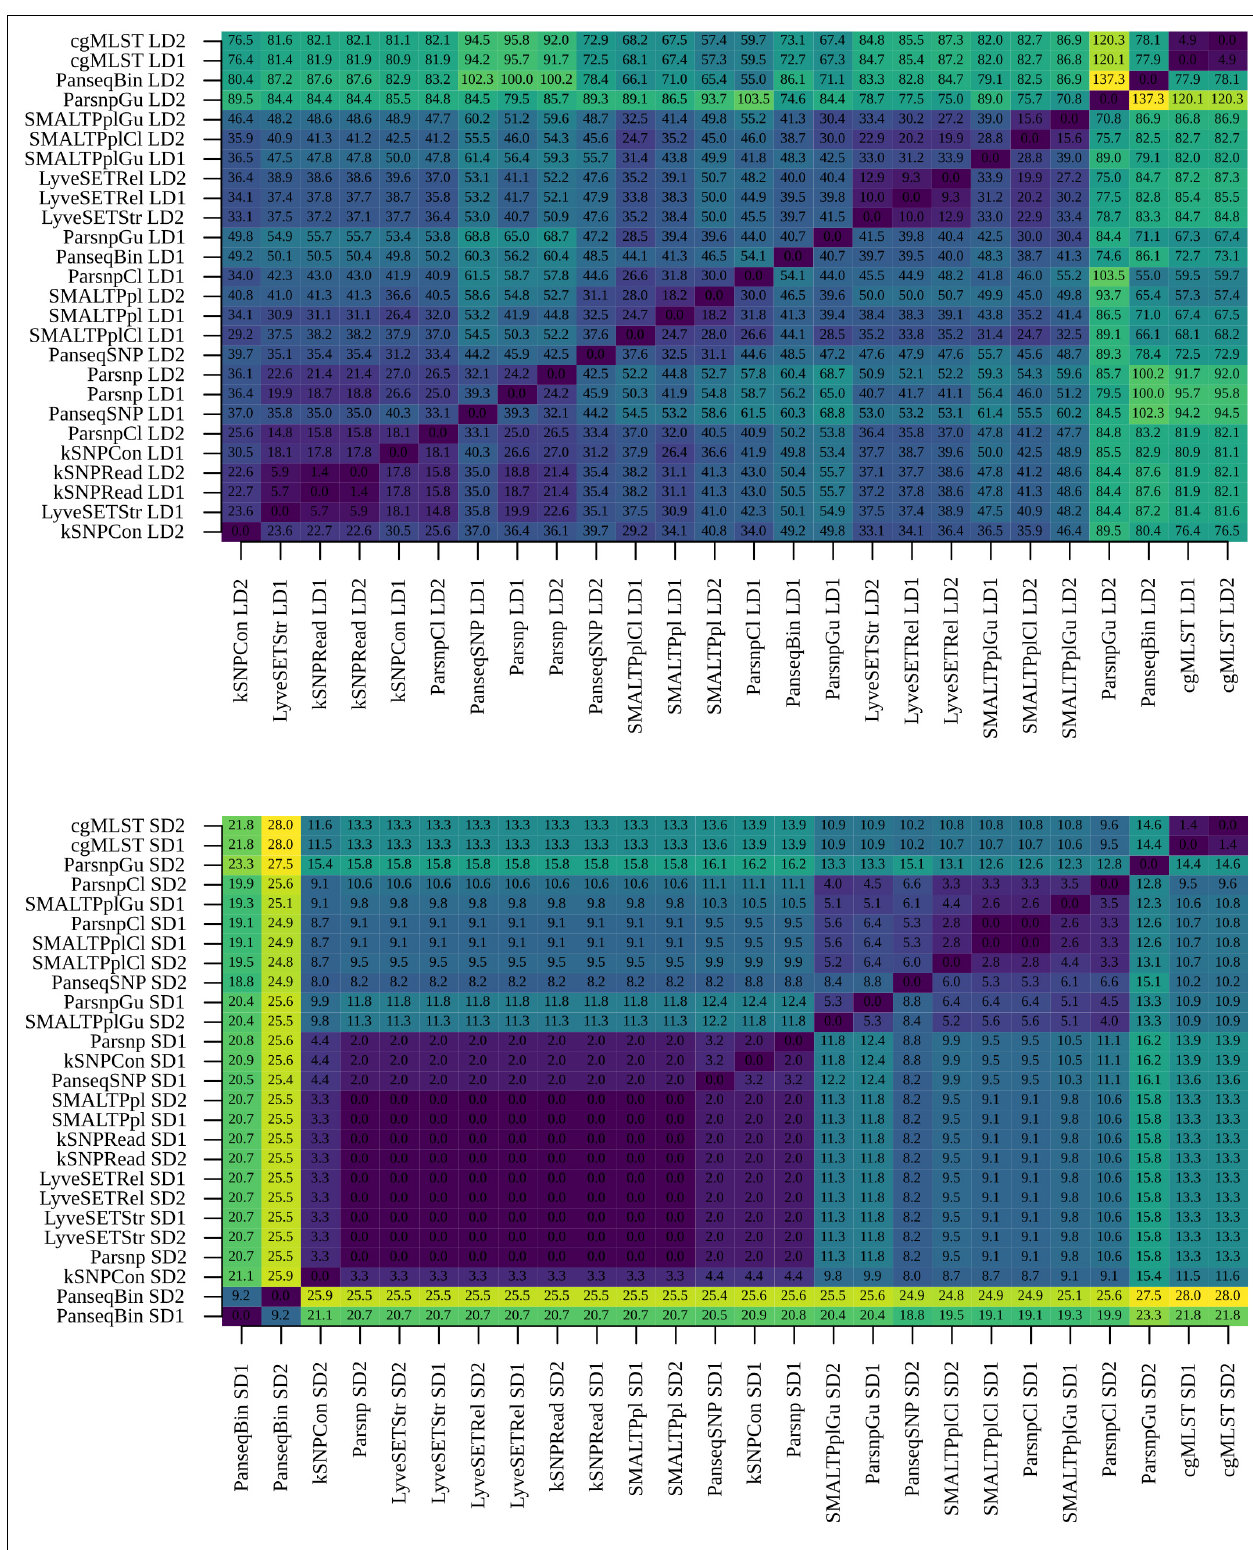
FIGURE 6 | Comparison of phylogenetic trees between pipelines. Phylogenetic trees generated using B:NT cc-269 isolates from large datasets (LD1 and LD2) (upper panel) and small dataset (SD1 and SD2) (lower panel) were compared using Kendall–Colijn (KC) test for topology ( λ = 0) and the obtained pairwise KC distances were